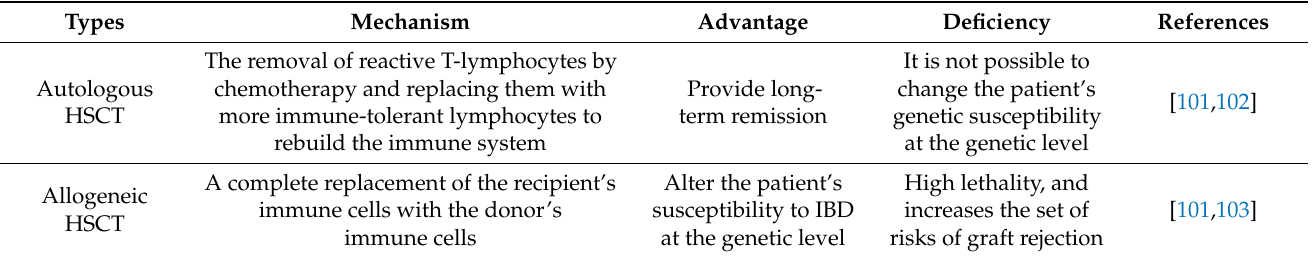
Table 2. Different types, mechanisms, advantages, and disadvantages of HSCT for